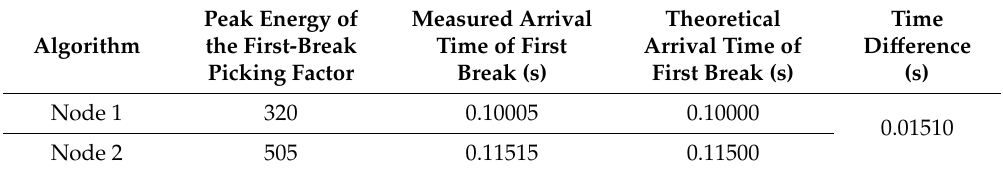
Table 1. The first-break arrival wave of the two nodes.